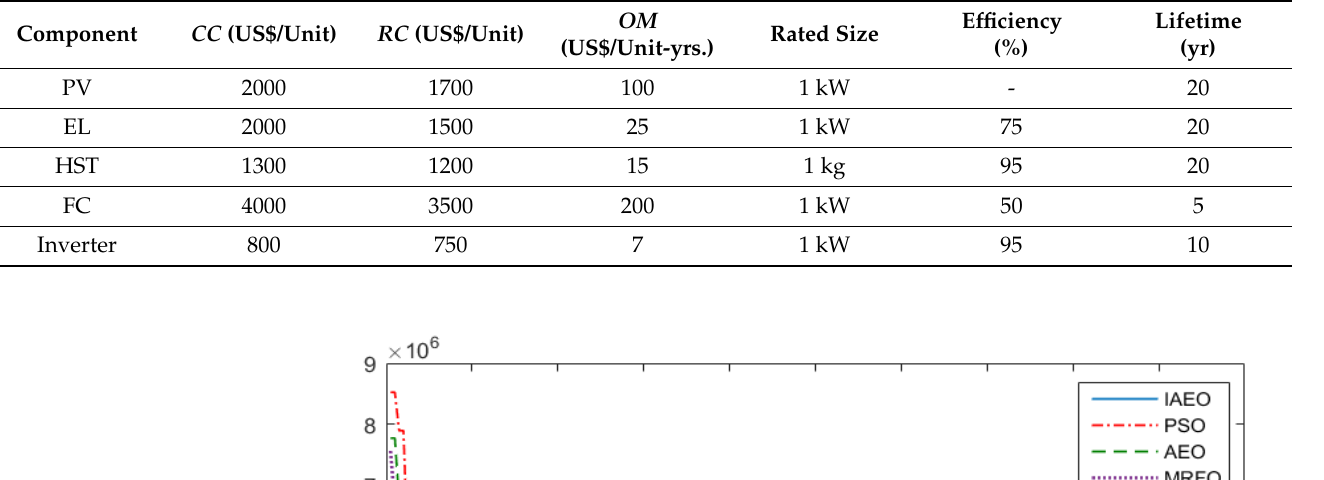
Table 1. Techno-economic data of the PV/FC energy system [15,36].